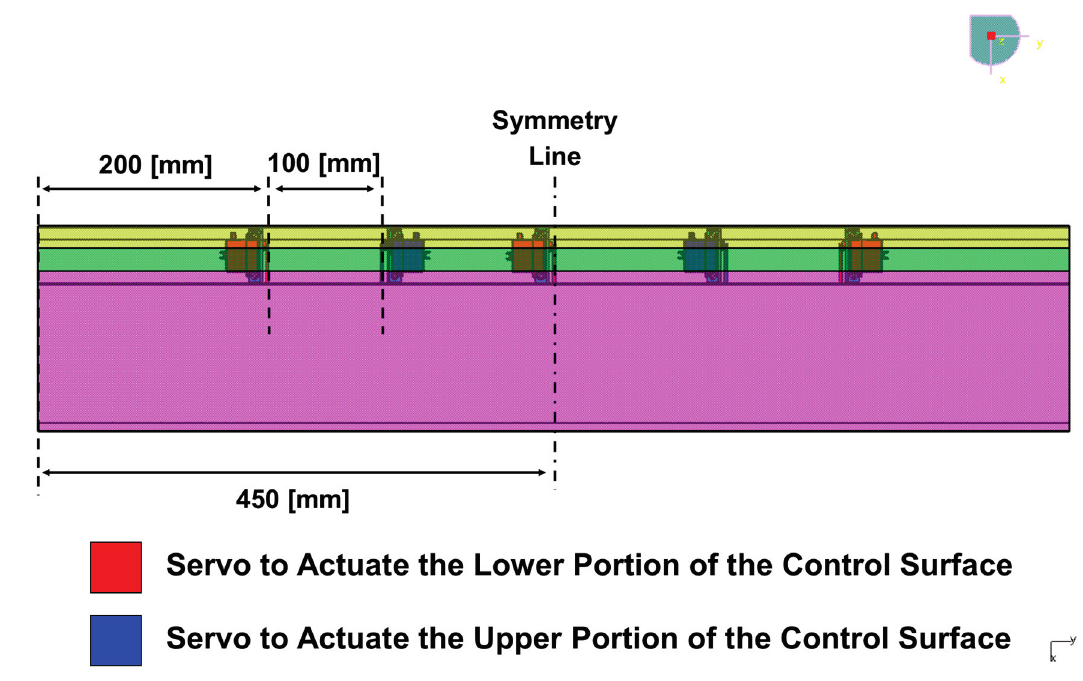
Figure 8. Top view of servo actuators in a five servo actuator